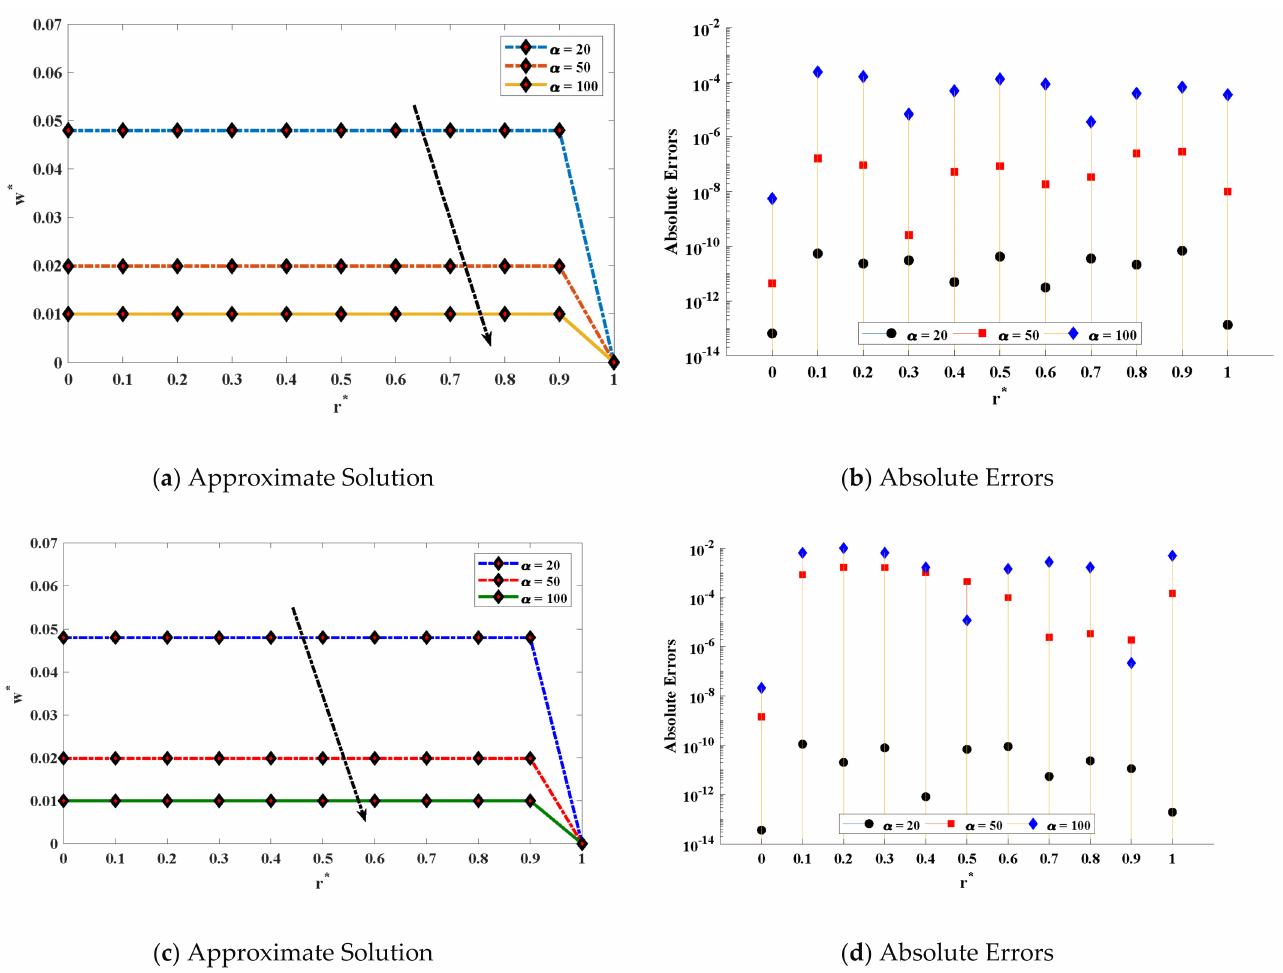
Figure 8. ( a – c ) shows the approximate solutions and ( b – d ) dictates the absolute errors in results obtained by the ANN- GNDO-SQP algorithm for Equation (8) with Ha 2 = 49 and